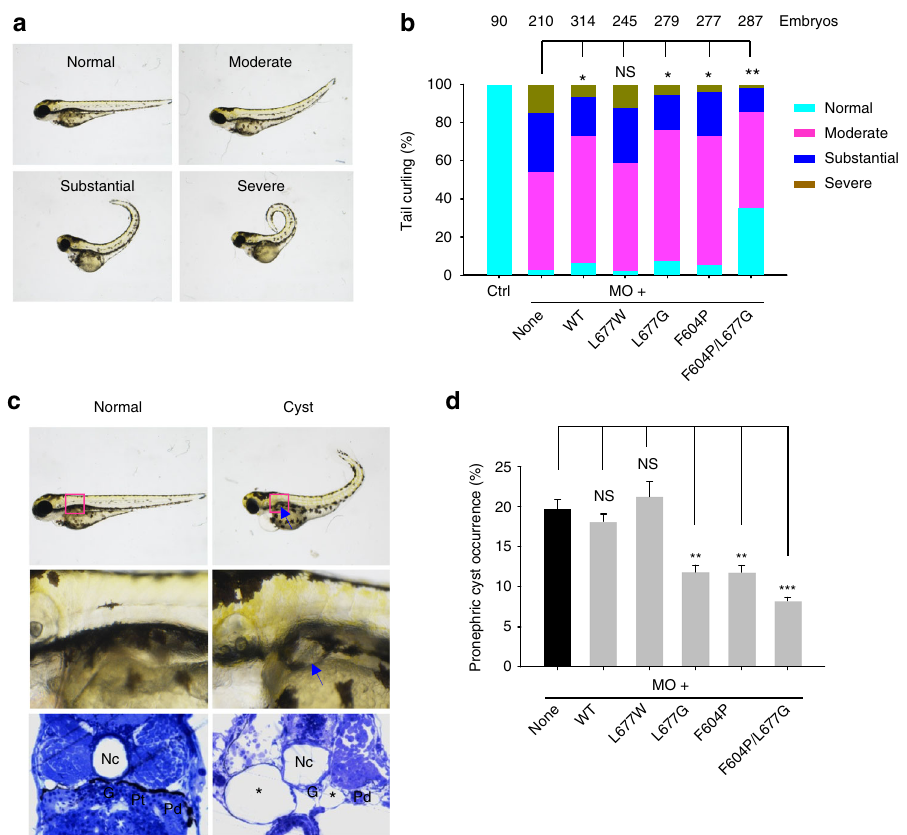
Fig. 4 Rescue of PKD2-associated zebra fi sh phenotypes by PKD2 gate mutants. a Representative zebra fi sh embryos showing different severities in tail curling induced by PKD2 MO knockdown. Normal (no curvature), Moderate (signi fi cant curvature, <90°), Substantial (90° – 180°), and Severe (>180°). b Averaged percentages of embryos with Normal, Moderate, Substantial and Severe tail curling at 3dpf. Embryos were co-injected with 2.5 ng PKD2 MO together with none or 100 pg mRNAs of WT or mutant PKD2, as indicated. Ctrl, uninjected embryos. Data were from three independent experiments with the indicated total numbers of embryos. Statistic signi fi cance was determined by the χ 2 test. NS, no signi fi cance; * P < 0.05; ** P < 0.01. PKD2 F604P mutant serves as a positive control. c Water-injected (Normal) and PKD2 MO-injected (Cyst) zebra fi sh embyros at 3 dpf showing curly tail and pronephric cyst formation (arrows) which is con fi rmed by a histologic section that also displayed dilated pronephric tubules (asterisks). G, glomerulus; Pt/Pd, pronephric tubule/duct; Nc, notochord. d Averaged percentages of embryos exhibiting pronephric cysts under the same conditions as those in b . Data are presented as mean ± SEM. Statistic signi fi cance was determined by Student ’ s t -test. NS, no signi fi cance; ** P < 0.01; *** P < amino acid identity, or lower channel activities of GOF PKD2 mutants in zebra fi sh pronephric cells compared to those in Xenopus oocytes. Taken together, these data indicate that L677G acts as a GOF mutation in vivo in zebra fi sh.